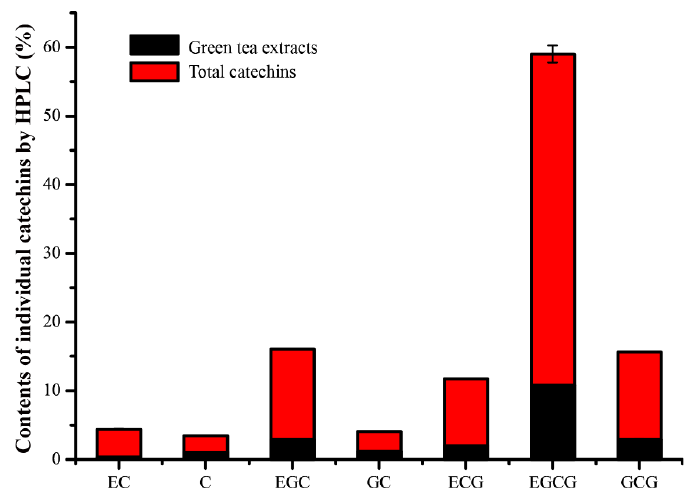
Figure 2. Individual catechin contents determined by